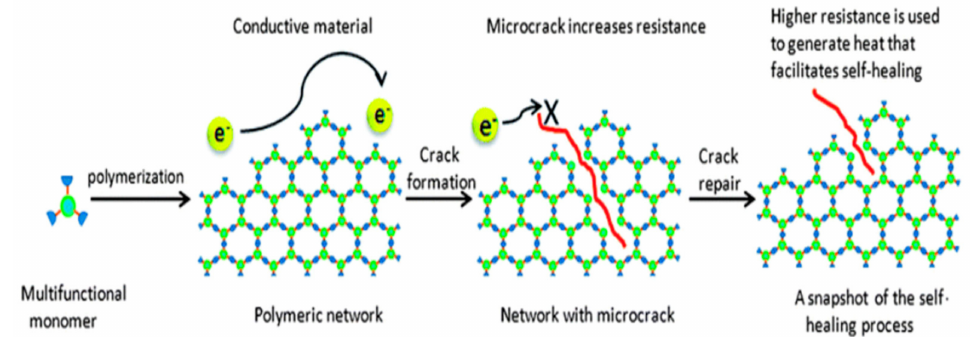
Figure 6. Fundamentals of electrically conductive self-healing materials. Electrical resistance increases upon formation of a microcrack, as the total number of electron percolation pathways decreases. As the microcrack is the source of the resistance increase, the generation of heat is localized at the fracture point according to the authors of